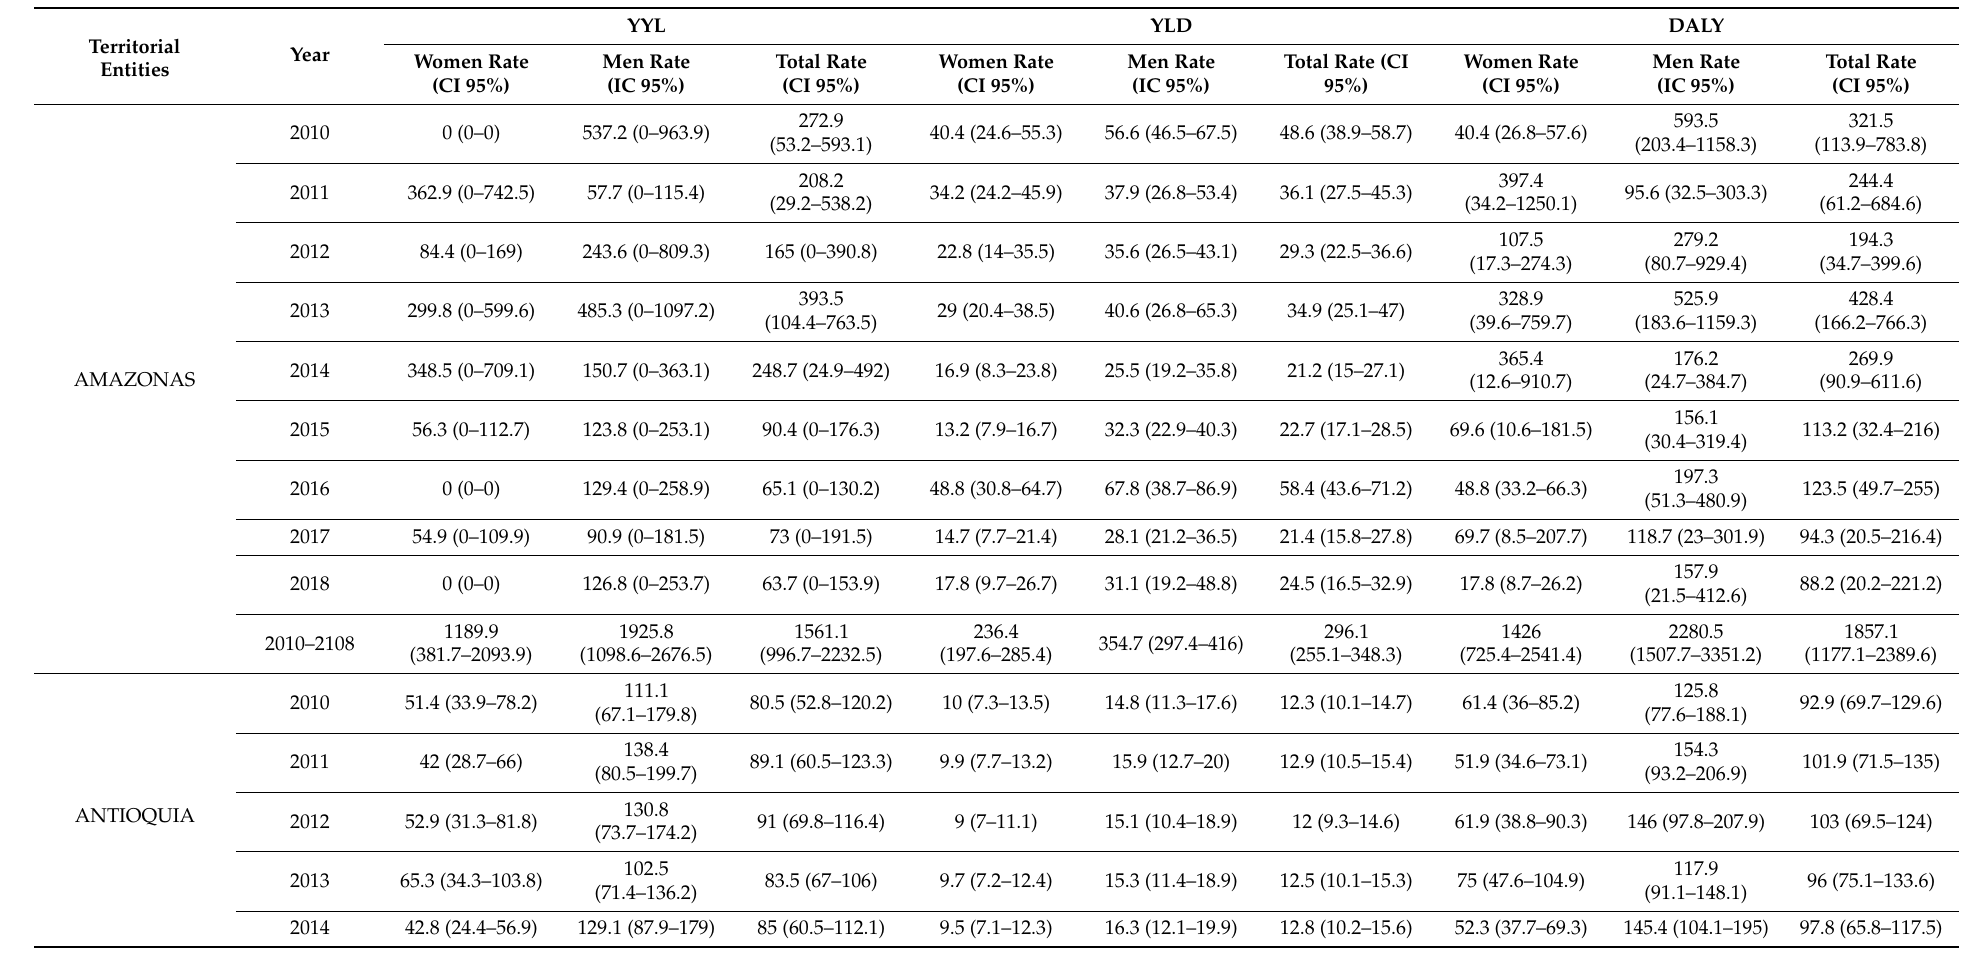
Table A1. Rate YYL. YLD and DALY by sex and territorial entities, Colombia,